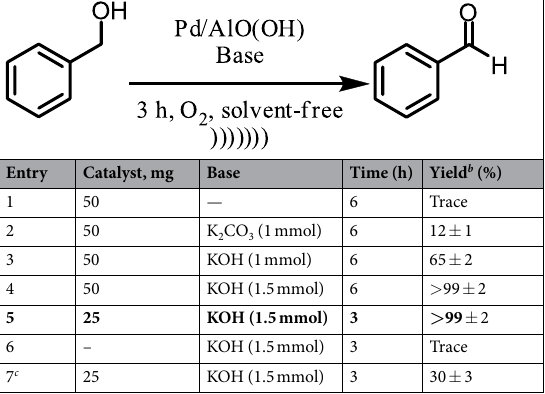
Table 1. Optimization experiments for the oxidation of benzyl alcohol to benzaldehyde. a Reaction Conditions: 1 mmol substrate, Aluminum oxy-hydroxide-supported palladium nanoparticles (0.5 wt % Pd), a continuous stream of O 2 . b Determined by 1 H NMR analysis. c At room